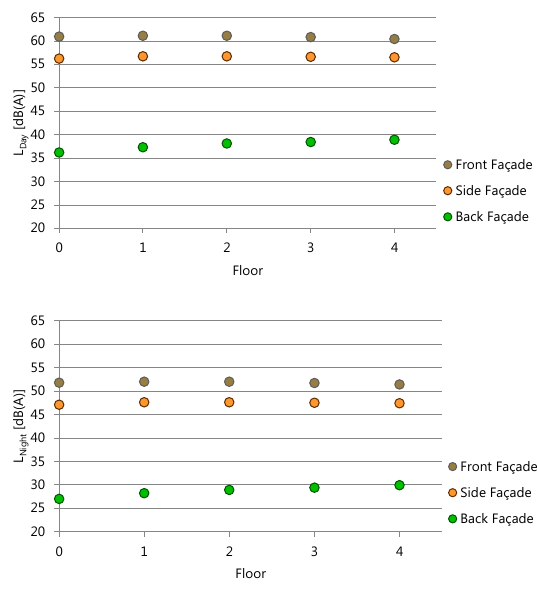
Fig. 7. Road traffic noise exposure at façade points for a single building for the period of 06:00-18:00 (L Day ) and 22:00-06:00 (L Night ).